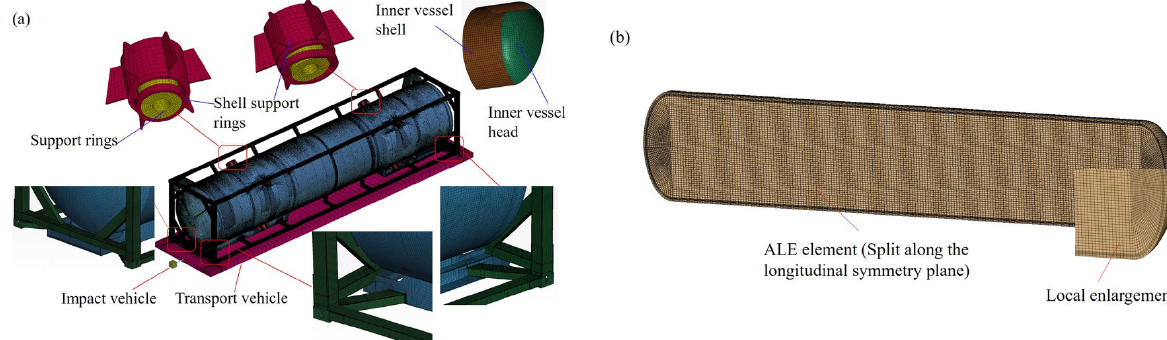
Figure 8. Mesh model: ( a ) structure, ( b ) ALE element (partial).